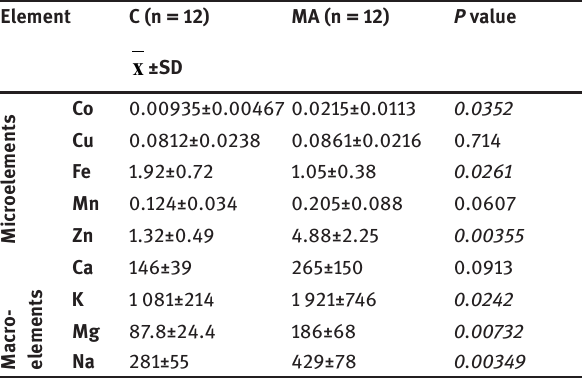
Table 11: The effect of enriched macroalgae on the average content of elements in urine of examined pigs (mg L -1 ).